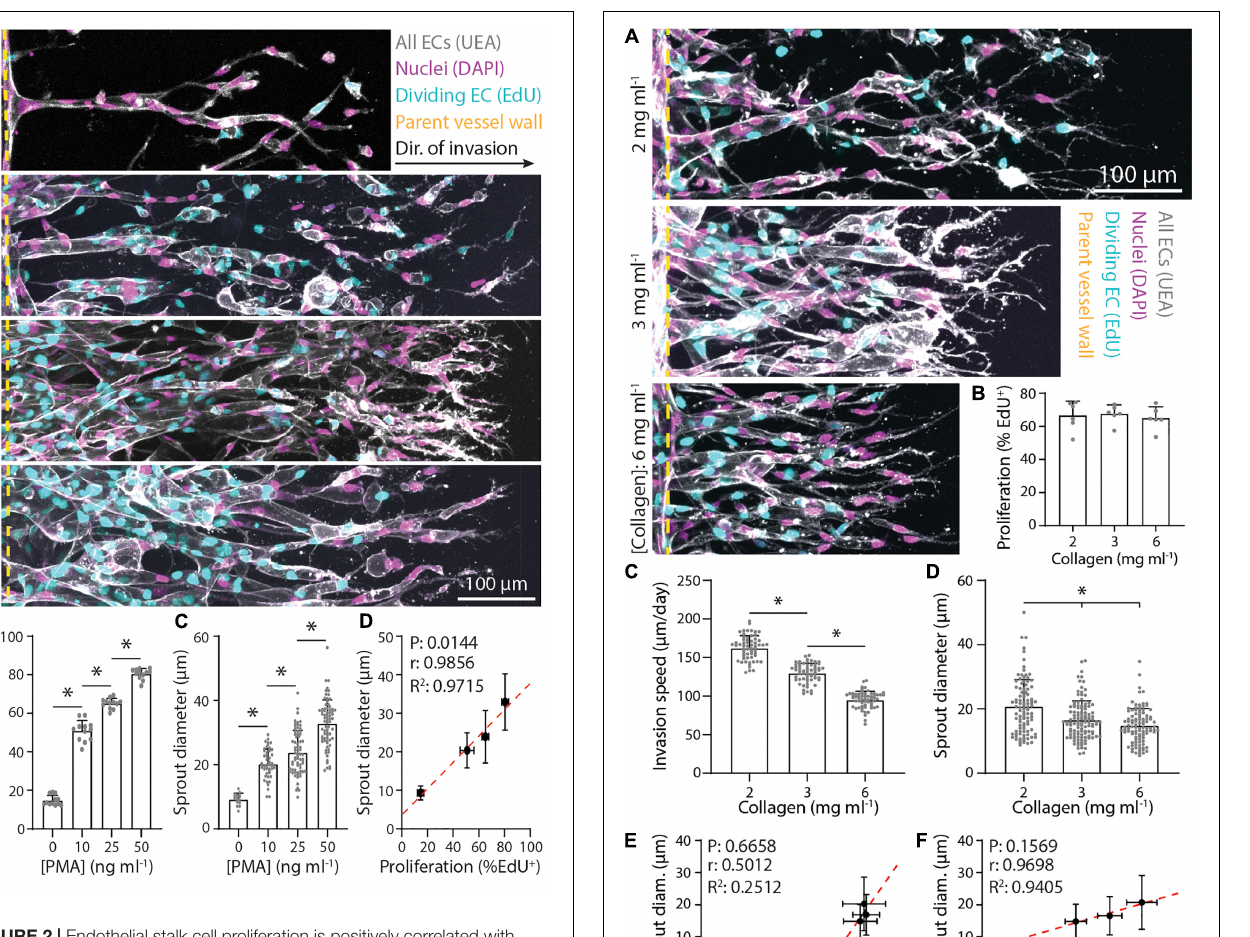
FIGURE 2 | Endothelial stalk cell proliferation is positively correlated with sprout diameter. (A) Representative images (max intensity projections) of invading endothelial cells (ECs) in response to varying phorbol 12-myristate 13-acetate (PMA). All conditions were cultured for 5 days with 250 nM sphingosine 1-phosphate (S1P) in endothelial cell growth medium 2 (EGM2; supplemented with indicated PMA) added to the chemokine channel within 3 mg ml − 1 collagen hydrogels. Ulex Europaeus Agglutinin-1 (UEA; white), nuclei (magenta), 5-ethynyl-2 (cid:48) -deoxyuridine (EdU; cyan), and yellow dashed lines indicate parent vessel edge. (B,C) Quantifications of proliferation and sprout diameter as a function of PMA. For proliferation: n ≥ 12 per condition and for sprout diameter: n ≥ 16 per condition. (D) Relationship between proliferation and sprout diameter, with red dashed line indicating a linear regression and statistical analysis performed by Pearson’s correlation. Sample size for each mean is identical to those of panels (B,C) . All data presented as mean ± SD; *indicates a statistically significant comparison with P < 0.05 (one-way ANOVA).